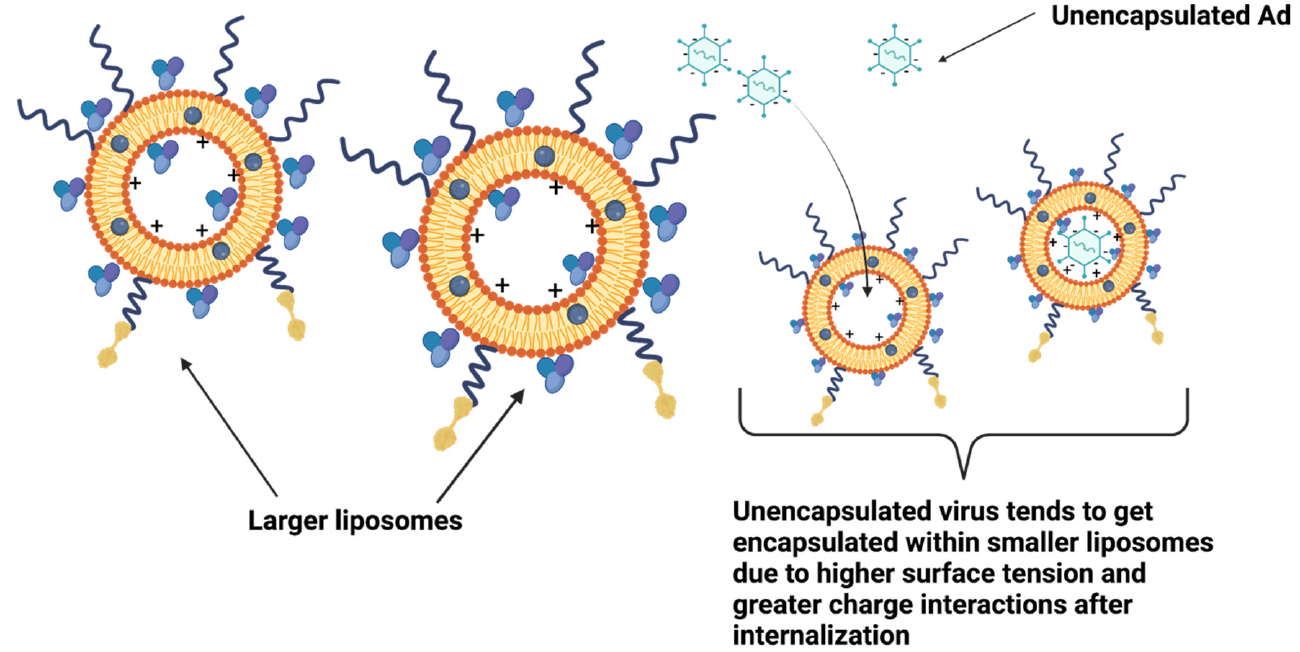
Figure 9. Spontaneous encapsulation of Ad in empty liposomes: unencapsulated virus tends to get